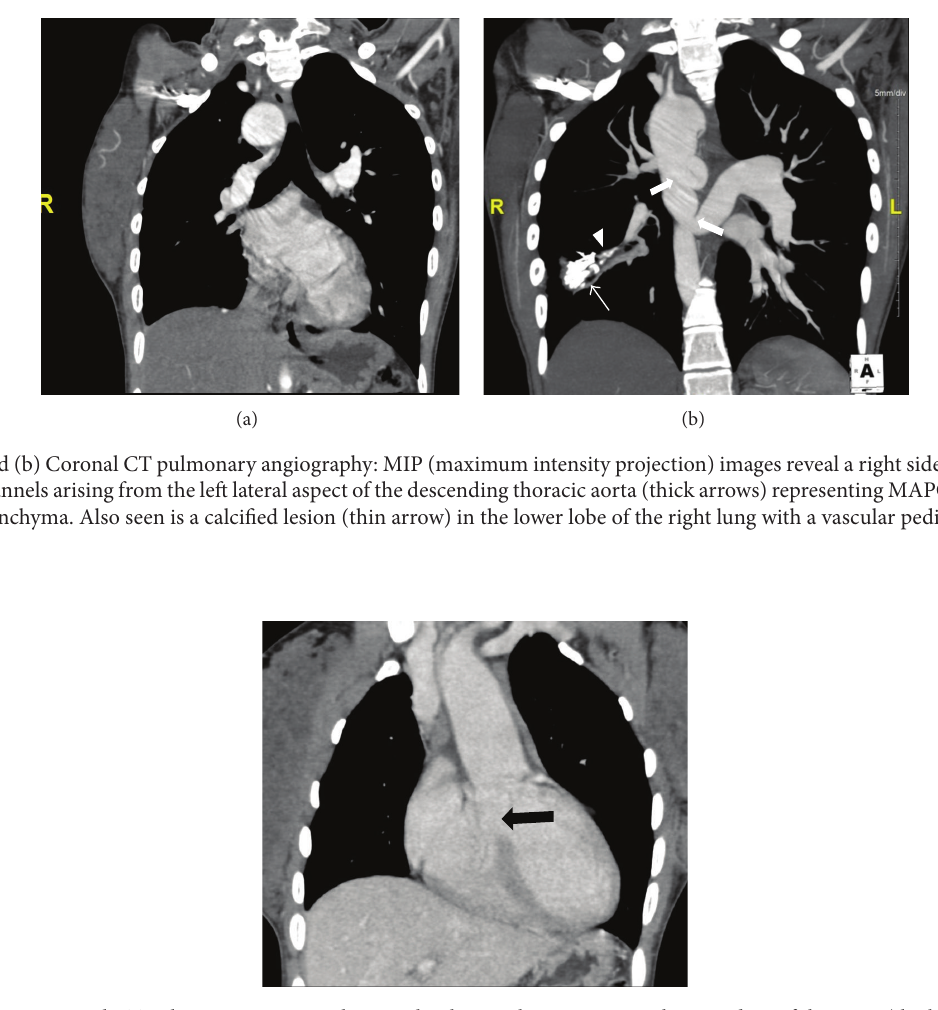
Figure 5: Coronal CT pulmonary angiography reveals a large subaortic VSD with overriding of the aorta (thick arrow).